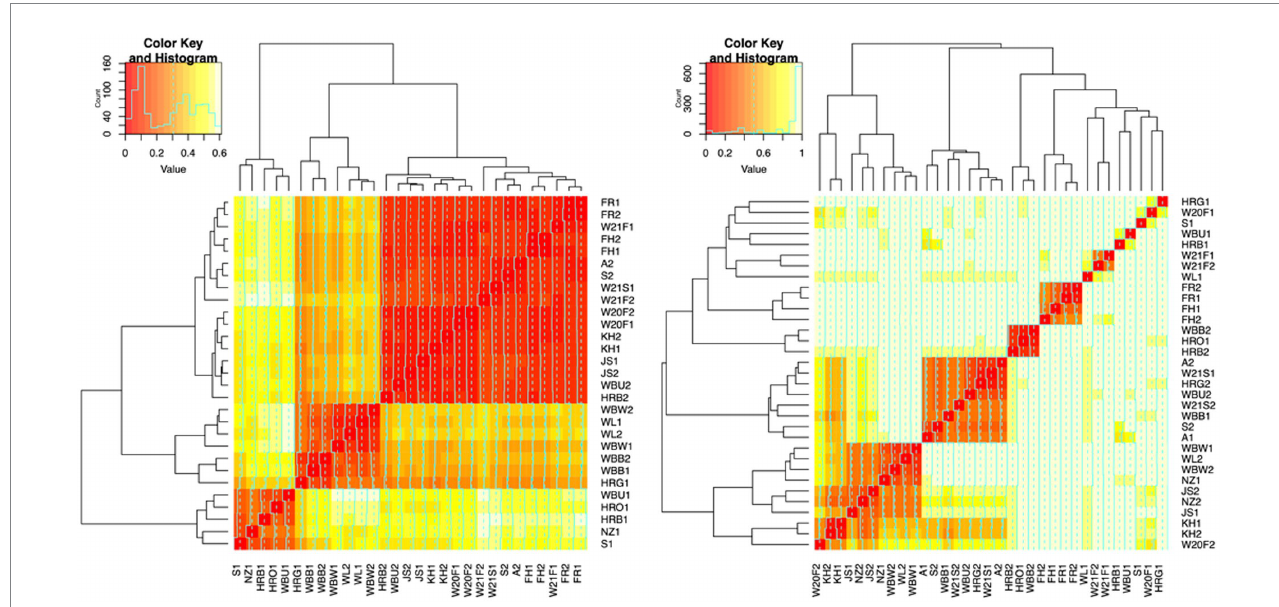
FIGURE 6 Heat maps of Bray-Curtis distances between honey bacterial and fungal community. Left: bacterial community. Right: fungal community. Each line and column represented a honey sample. The degree of similarity based on Bray–Curtis distances was represented by the color and dendrogram. Color red represented high similarity while light yellow represented low similarity. Samples grouped together in the dendrogram were highly similar. Color key and histogram in the top left corner of the heat map represented the distribution of Bray–Curtis distances. The distance of the line from the center of each color-cell is proportional to the distance value. Axis labels are colored based on honey type: monofloral (black), wildflower (red), manuka (green), feral